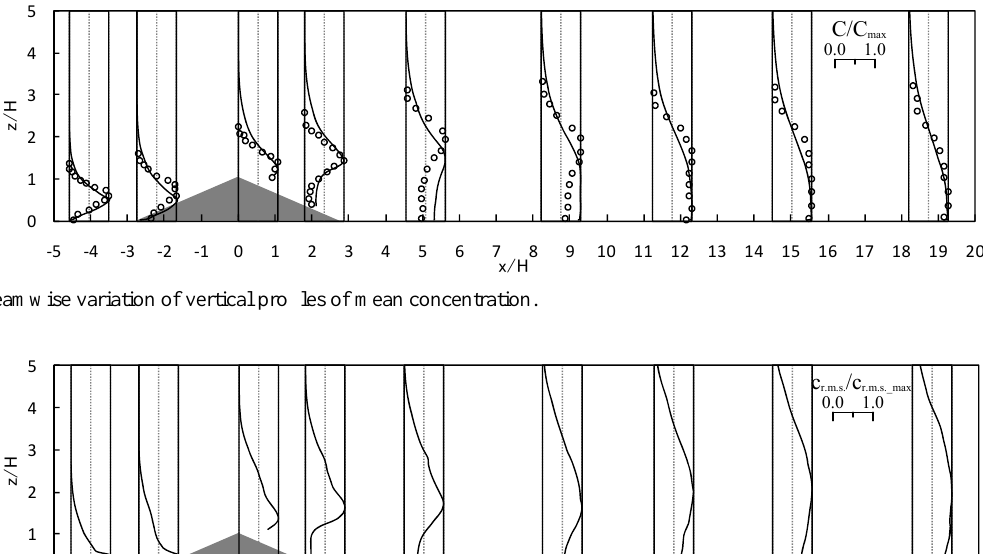
Fig. 6. Streamwise variations of mean concentration near the ground level.